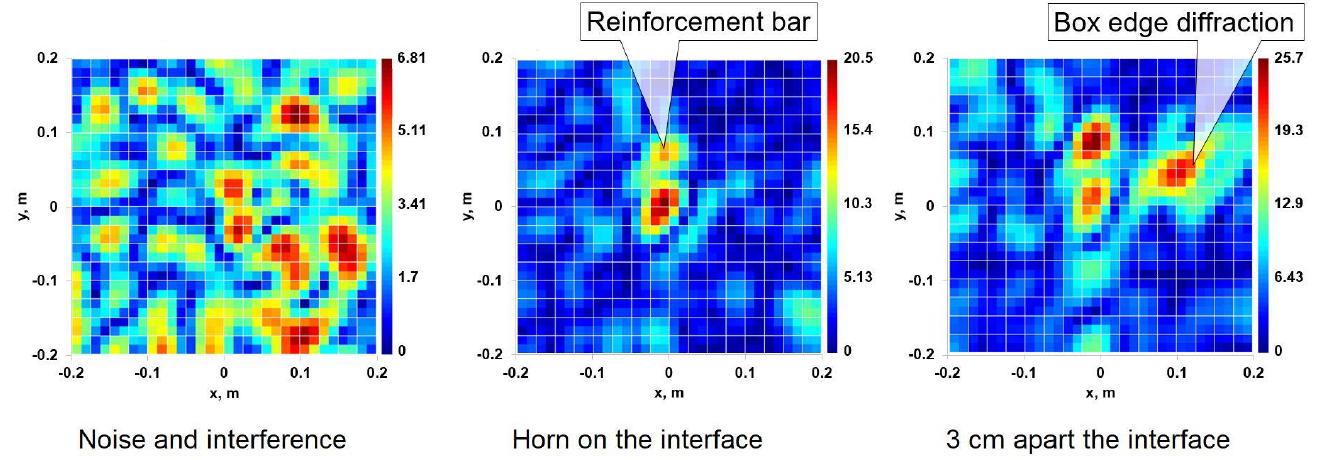
Figure 6. Radar signal from a reinforcement bar in sand (steel, 14 mm in diameter), side-wall illumination — see Figure 5a.